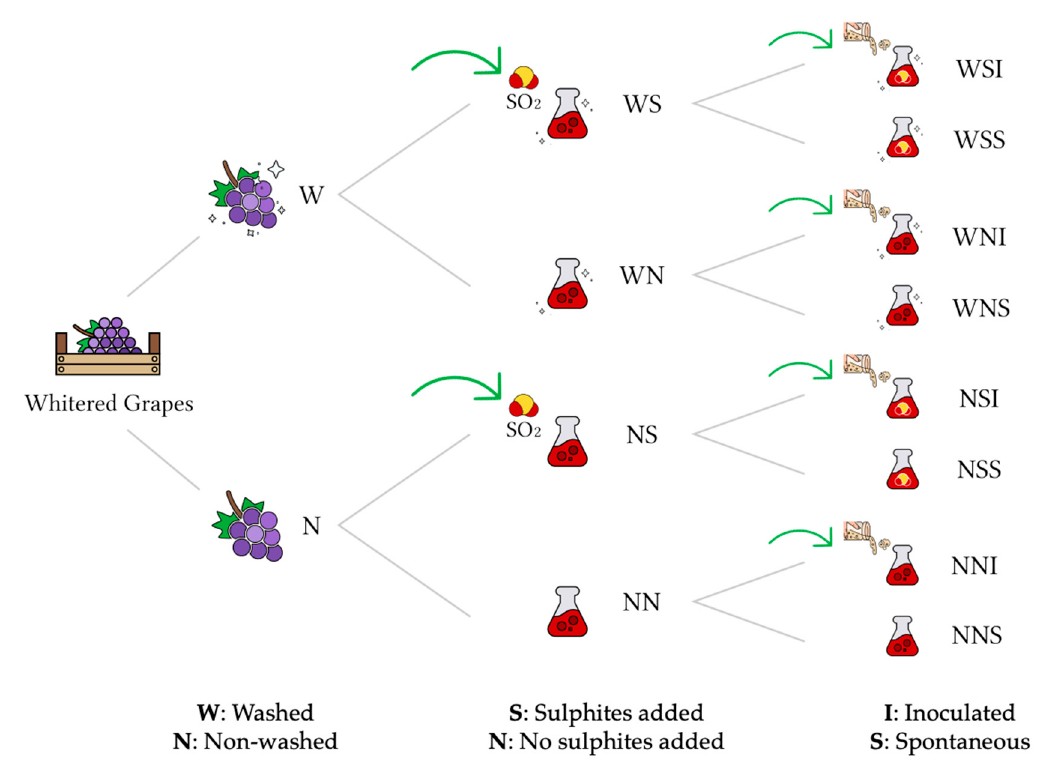
Figure 1. Schematic representation of the experimental plan, with the eight different modalities of winemaking carried out and the acronyms explained.